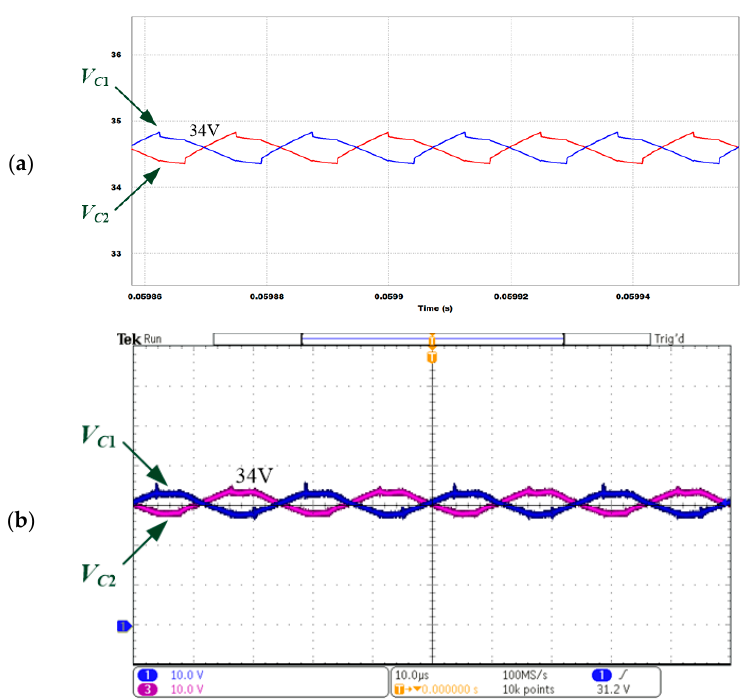
Figure 18. Waveforms of the combined boost converter for the cross voltages across C 1 and C 2 . ( a ) Simulated waveforms; ( b ) Experimented waveforms.